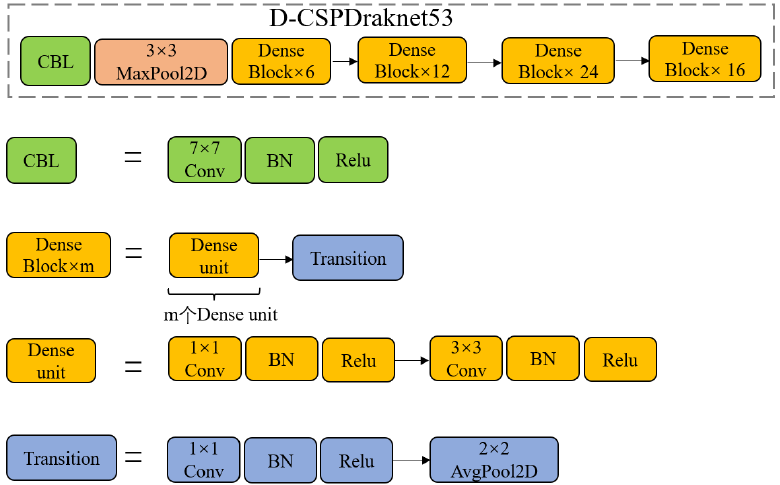
Figure 4. D-CSPDraknet53 structure diagram. 3 × 3 MaxPool2D: Max-Pooling with kernel size 3 × 3, Strides = 2; 7 × 7 Conv: Convolution with kernel size 7 × 7, Strides = 2; 7 × 7 Conv: Convolution with kernel size 7 × 7; 1 × 1 Conv: Convolution with kernel size 1 × 1; 2 × 2 AvgPool2D: Avg-Pooling with kernel size 2 × 2, Strides = 2.